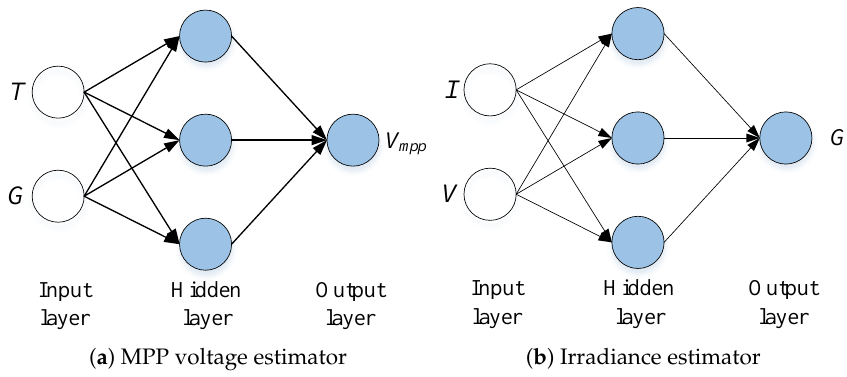
Figure 5. The architecture of the neural networks used for MPP voltage and irradiance